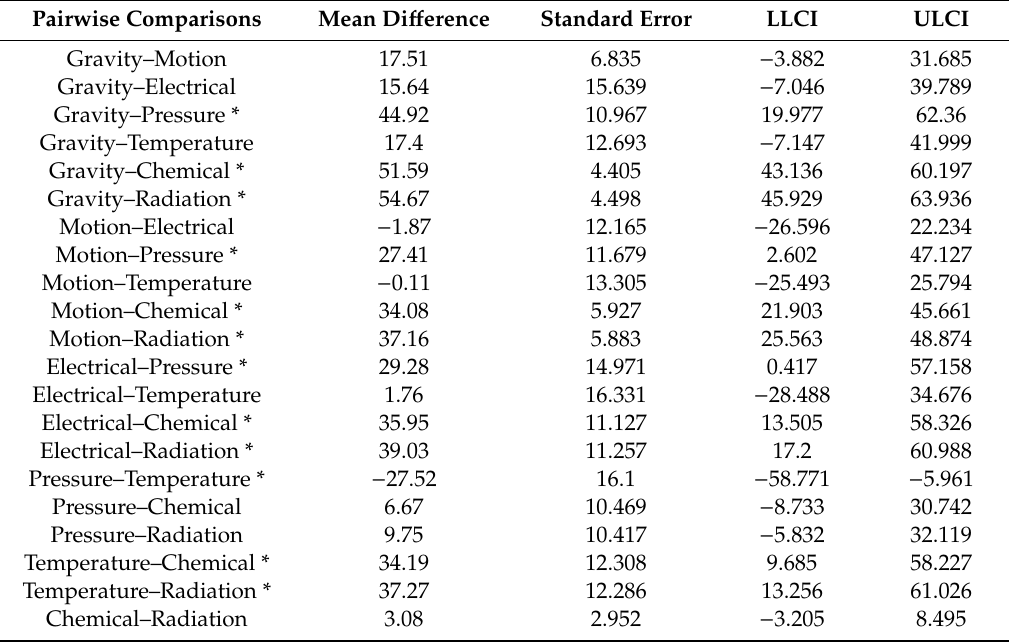
Table 3. Pairwise comparisons of demonstrated proficiency levels across the hazard categories.